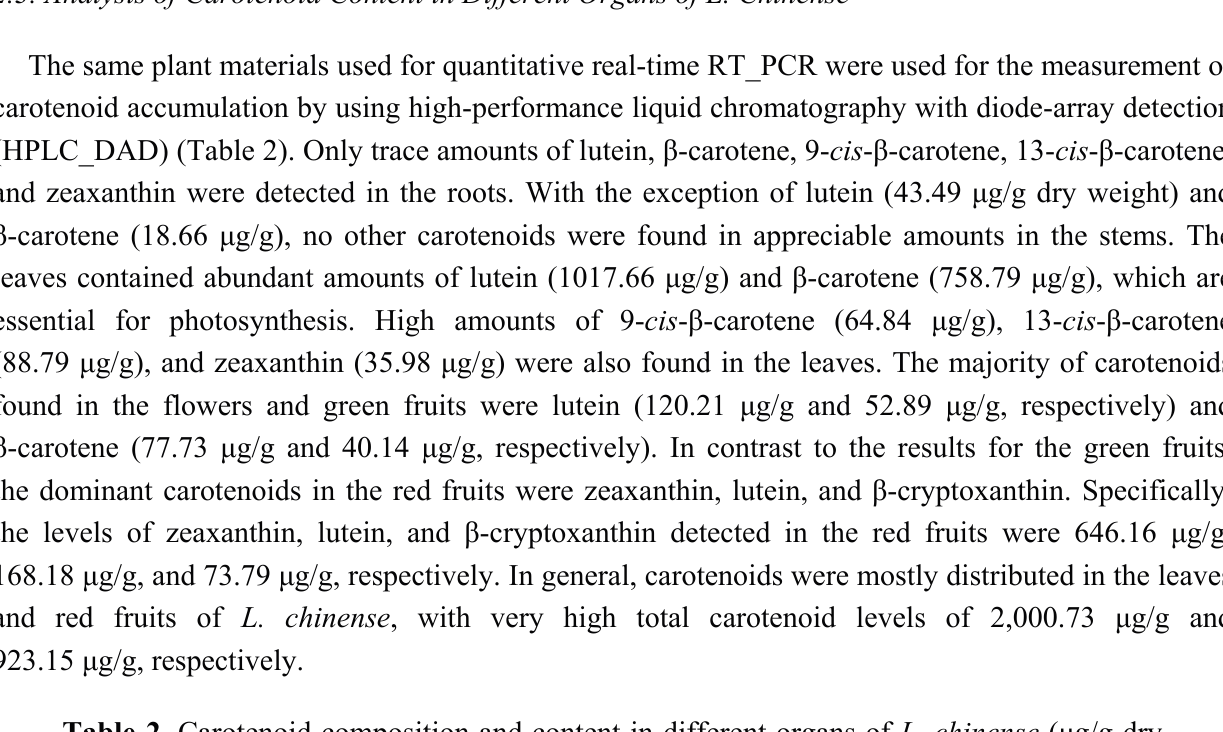
Table 2. Carotenoid composition and content in different organs of L. chinense ( μ g/g dry weight). The results have been expressed as mean ± standard error values from 3 independent measurements. N.D. = not